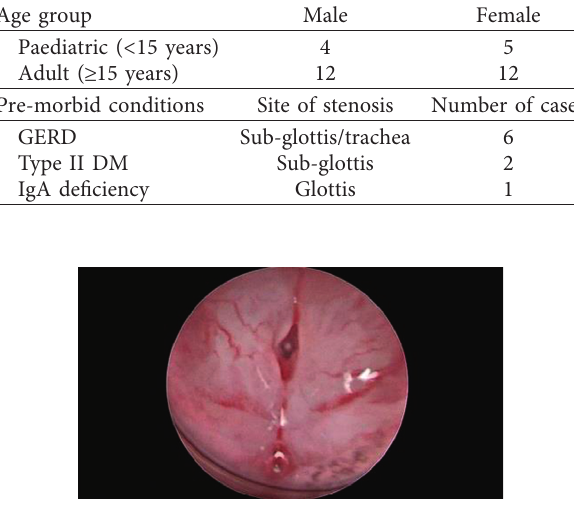
Figure 1: Circumferential glottic stenosis.